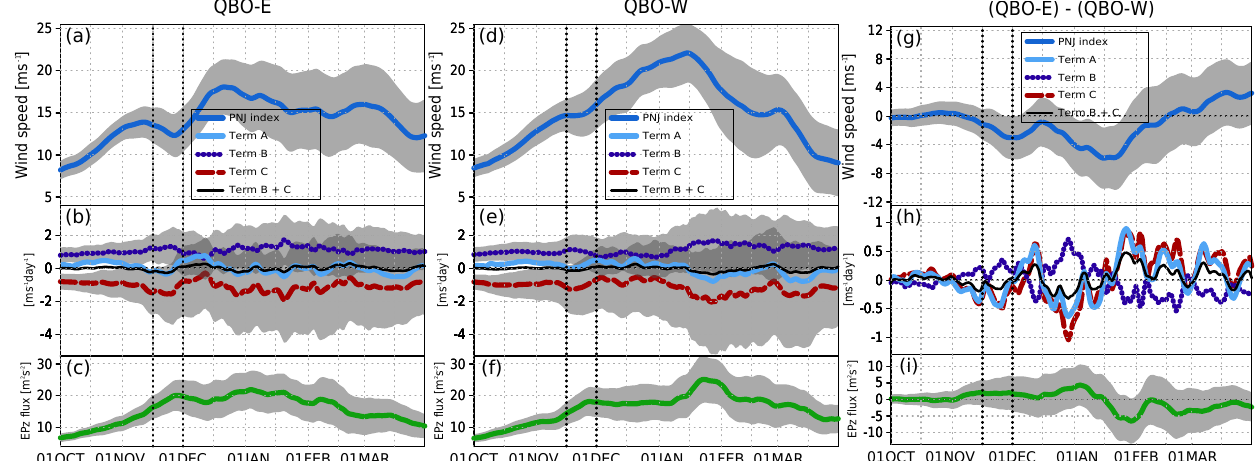
Figure E1. Same as Fig. 2, but (a) – (c) for QBO-E, (d) – (f) for QBO-W, and (g) – (i) the difference between QBO-E and QBO-W.